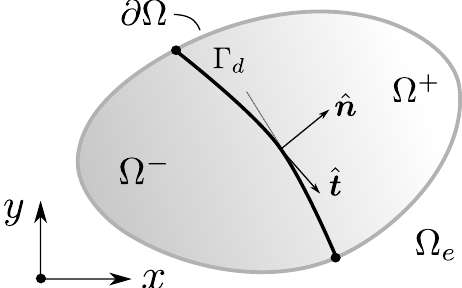
Figure 2. Basic schematic of an embedded strong discontinuity in